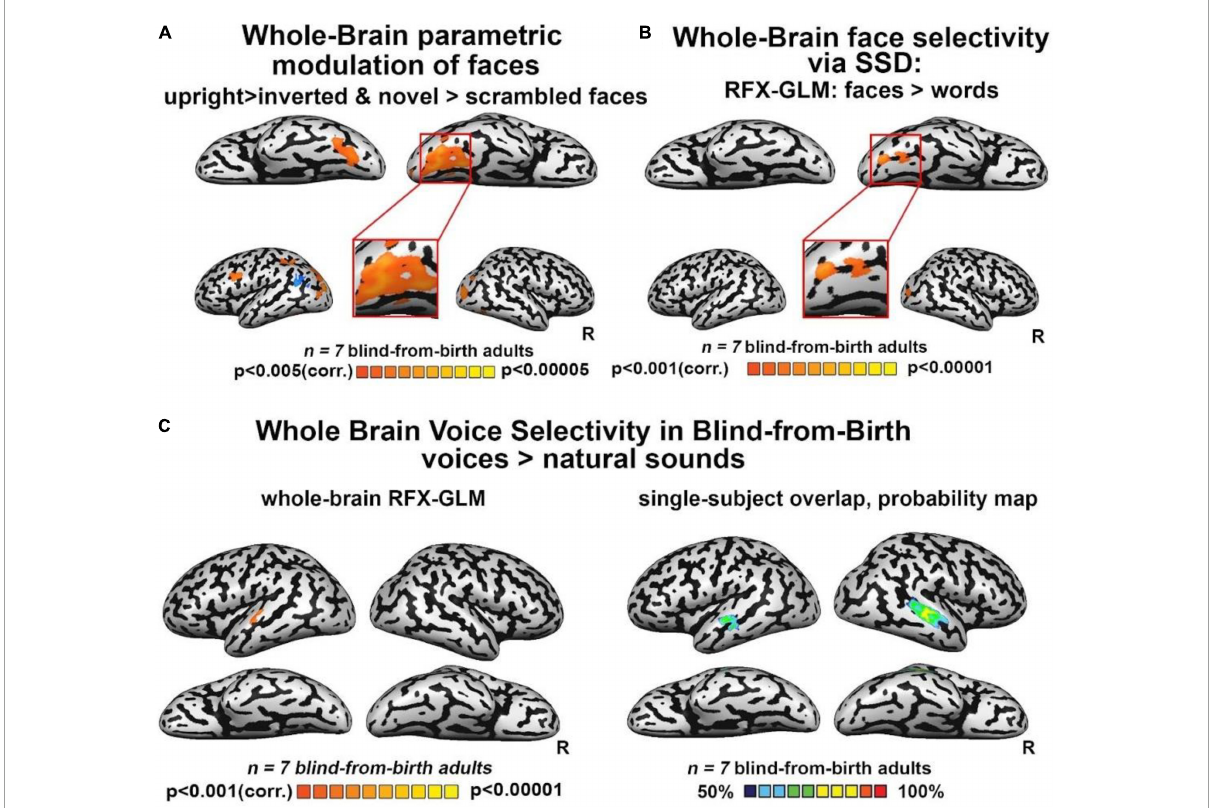
FIGURE2 (A) Whole-brain parametric general linear model (GLM) shows that bilateral clusters in fusiform gyrus (FG) are maximally activated by trained faces, then by face orientation and face novelty, and last by scrambled faces. A similar modulation was observed also for occipital face area (OFA) and inferior frontal gyrus (IFG), two other cortical regions known to be involved in face processing. (B) Whole-brain RFX-GLM with the contrast Faces > Words shows recruitment of the right FG (Talairach coordinates of peak 31, –57, –16), together with a cluster in the right middle occipital gyrus, including OFA, another cortical region known to prefer face-related information. (C) Human voices > natural sounds. Left: RFX-GLM analysis shows the expected recruitment of the left superior temporal gyrus (Talairach coordinates: –60, –19, 10), compatible with the known location of the TVA but crucially, no recruitment of FG. Right: The probability map obtained from the overlap of single participants’ activations for the same contrast, reveals consistent activations in the bilateral TVA but crucially, no activation in the ventral visual stream nor in